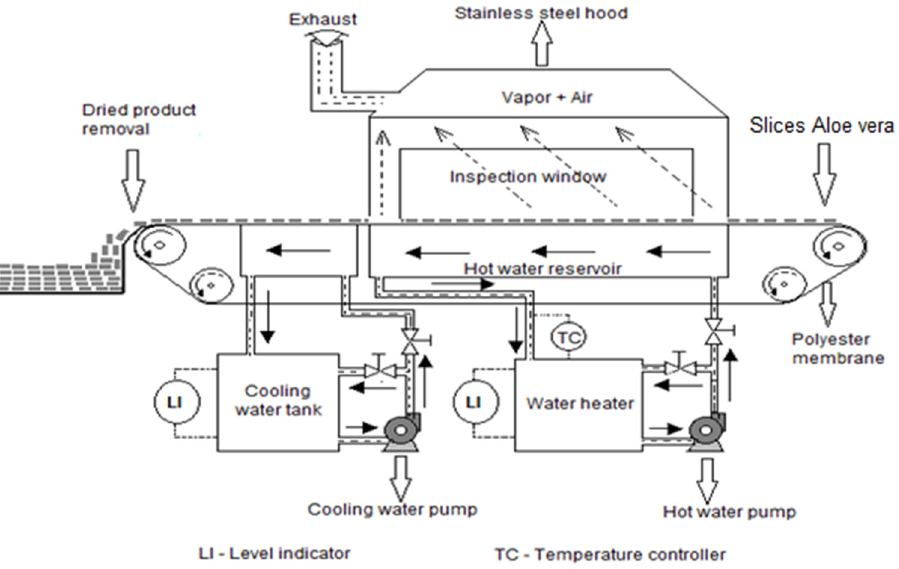
Figure 1. Schematic diagram of the Refractance Window ® continuous pilot dryer used in this work. Adapted from Ocoró-Zamora and Ayala-Aponte [27].